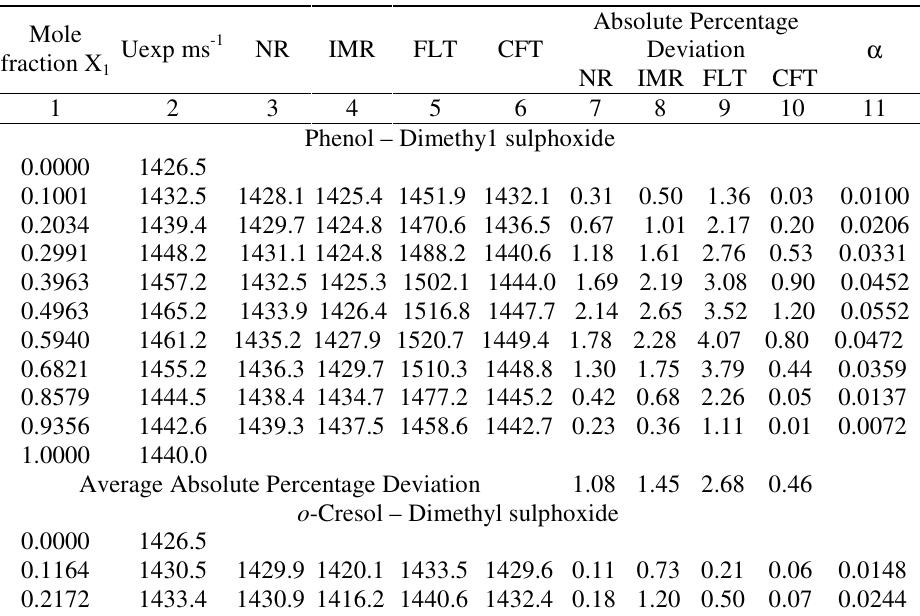
Table 1. Experimental and predicted ultrasonic velocity and their percentage deviation and degree of molecular interaction for the dimethy1 sulphoxide with phenol, o -cresol, p - cresol, m - cresol and p -chconophenol systems at